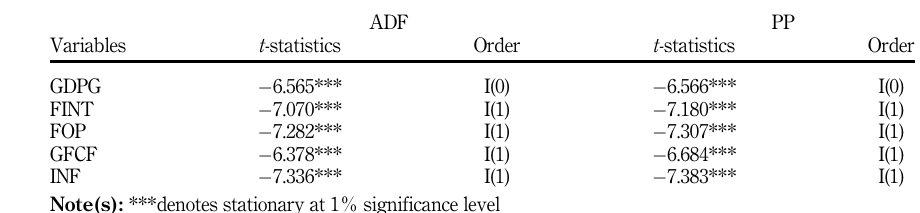
Table 2. Unit root test